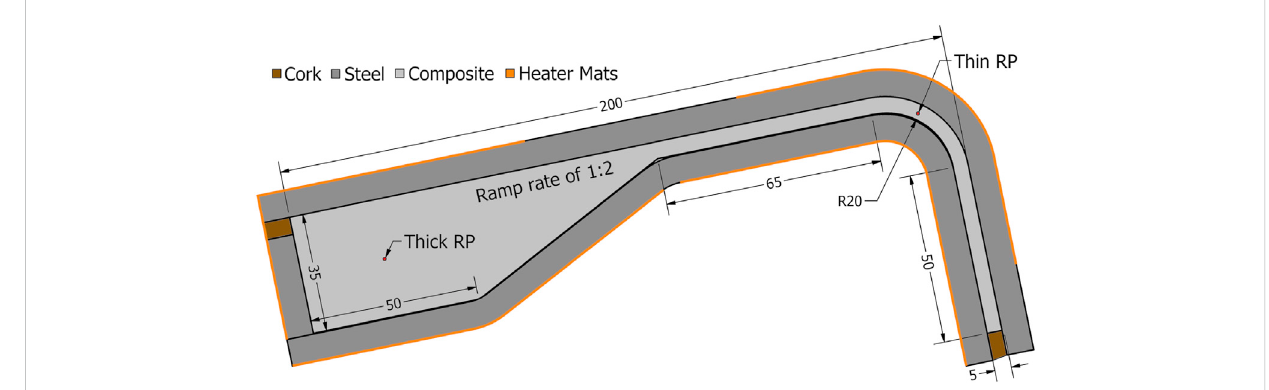
FIGURE 1 2D cross-sectional view of design, incl. tooling and qualitative indication of heater mat positions, with key part dimensions in